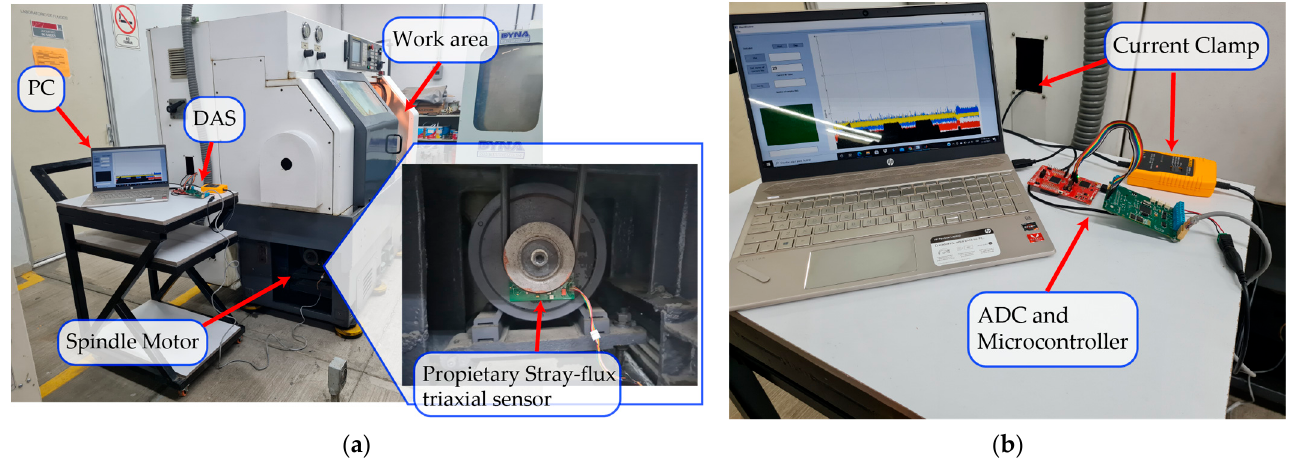
Figure 3. Experimental setup: ( a ) CNC location of the DAS for the capturing of the current and stray flux signals, spindle motor showing details of the colocation of the stray flux sensors on the spindle motor and work area for the tests; ( b ) close-up of the DAS components: AC current clamp, ADC and microcontroller. Table 2. 6061 Aluminum alloy composition by mass [46].